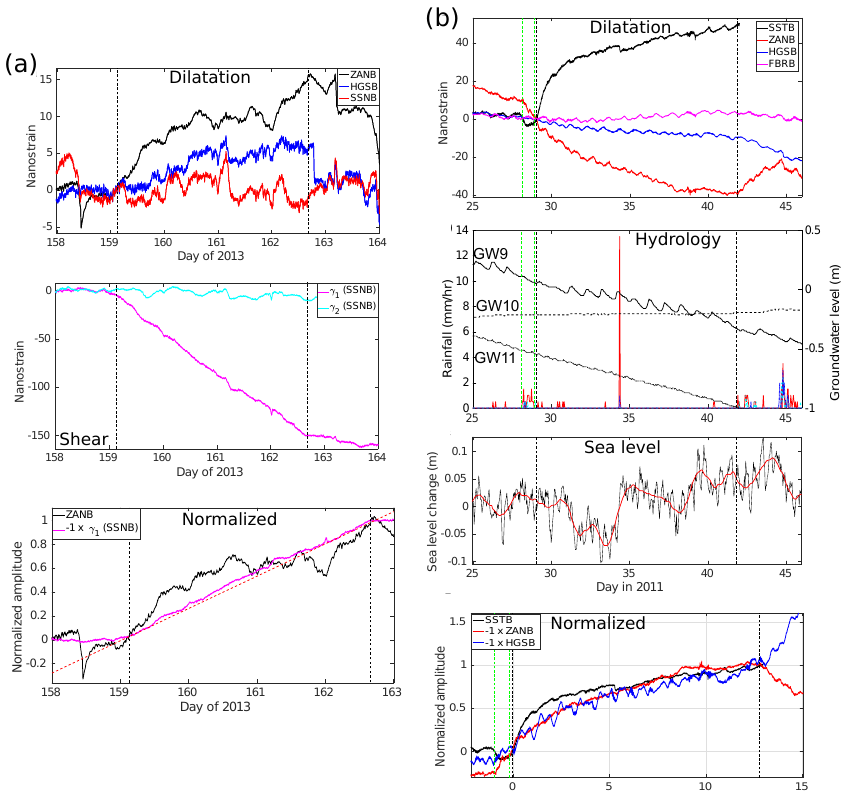
Figure 12. Detection of SSEs on the LVF using borehole strainmeters. ( a ) Dilatation and shear signals recorded in the Ruisui area associated with a M w ∼ 4.5 SSE in 2013. Figure adapted from Canitano et al. (2019) [5]. ( b ) Dilatation signals, hydrological perturbations (groundwater level: black curves, cumulative rainfall: red, blue and magenta bars) and sea level changes during the 2011 M w 5.5 SSE. Normalized strain time-series are signals normalized by the value reached at the end of the SSE episode. Vertical black and green dashed lines indicate the duration of SSE and light rainfall episodes, respectively. Figure adapted from Canitano et al. (2021)